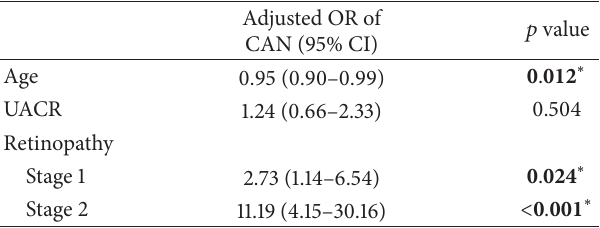
Table 4: Logistic regression analyses of risk factors for cardiovascu- lar autonomic